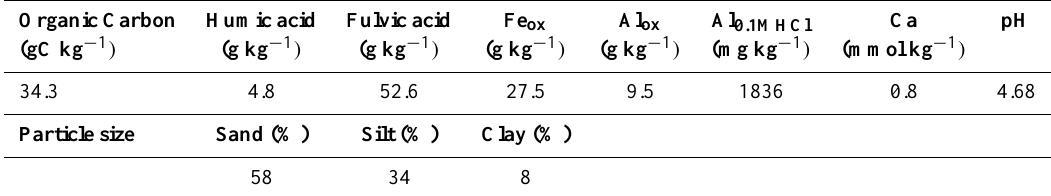
Table 3. Selected analytical properties of the Strichen Bs soil used in the equilibration experiments (taken from Filius et al., 2000). Fe ox and Al ox relates to amorphous hydrous oxide concentrations determined by acid ammonium oxalate extraction.